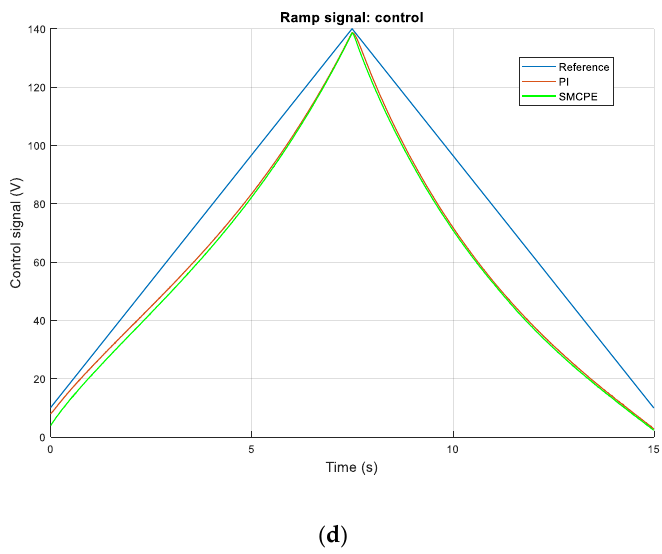
Figure 6. PI vs. SMCPE performance comparison for ramp signal tracking: ( a ) Position, ( b ) Position error, ( c ) Position – reference, and ( d ) Control signal.